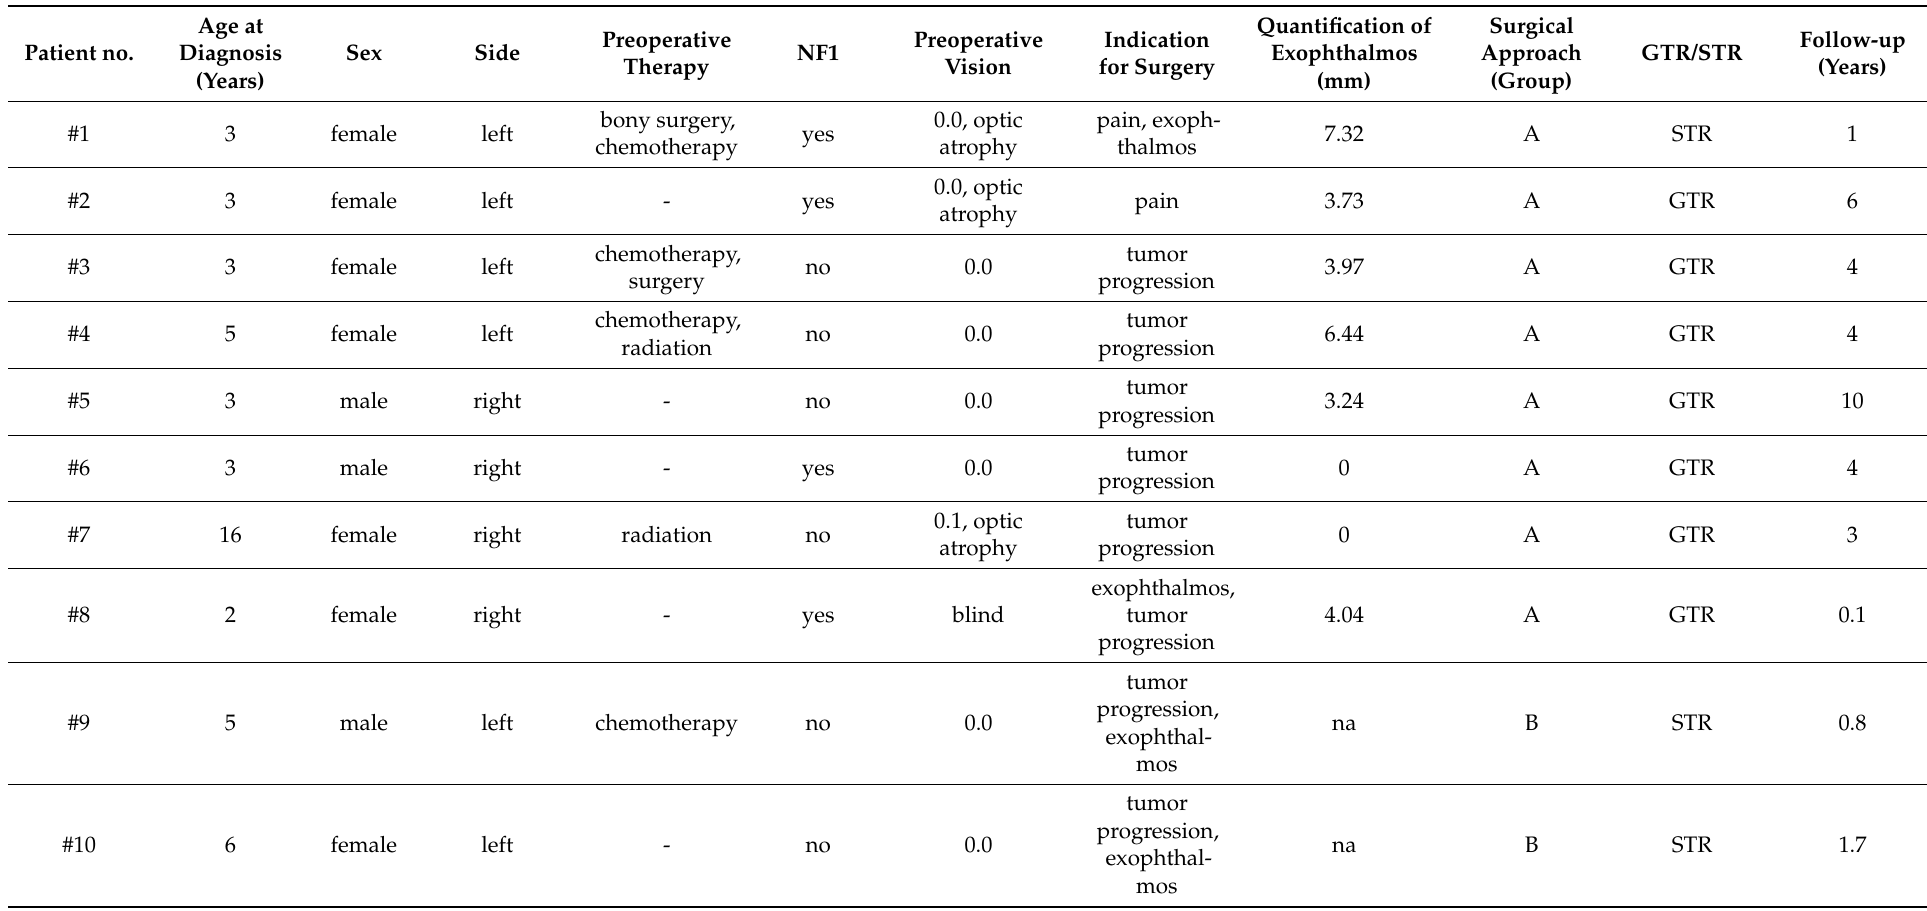
Table 1. Basic patient